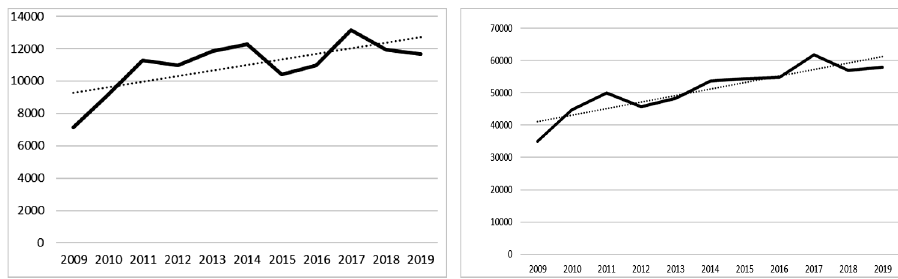
Figure 7. Total exports of V4 to China (USD, million)